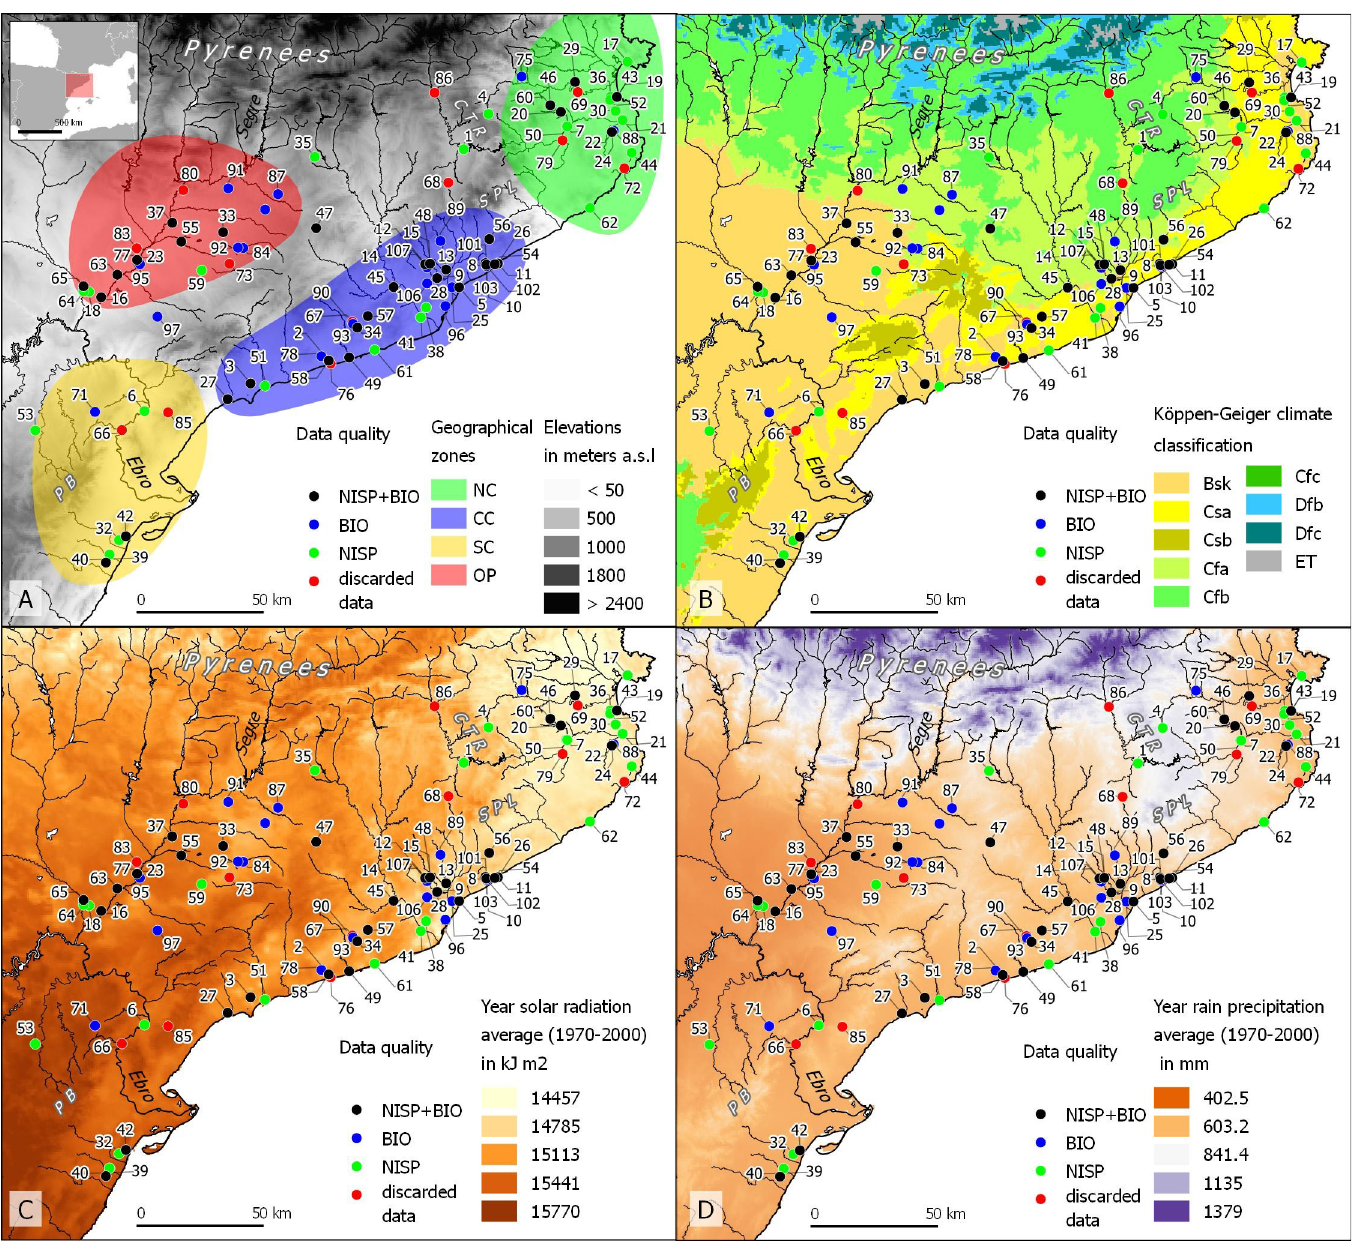
Fig 1. Map of NE Iberia with locations of the studied sites. A) Location of geographical areas (NC: North Coast, CC: Central Coast, SC: South Coast, OP: Occidental Plain) with sites colored depending of archaeozoological data availability (NISP: Counts by species, BIO: Biometrical data) with elevation map reprinted using open data from Geofabrik and the U.S. Geological Survey [55,56]; B) Ko¨ppen-Geiger climate classification reprinted from open data Zenodo [57]. The classification is based on threshold values and seasonality of monthly air temperature and precipitation. Considering vegetation as “crystallized, visible climate” C) Averages of year solar radiations between 1970–2000 [58]. D) Averages of rain precipitations between 1970–2000 [58] reprinted from WorldClim (CC-BY SA 4.0). List of sites: 1. Esquerda ; 2. Alorda Park; 3. Antigons; 4. Aubert; 5. Baetulo; 6.Barranc de G à fols; 7. Bosc del Congost; 8. Burriac; 9. Ca n’Oliver; 10. Can Bartomeu; 11. Can Cruzate; 12. Can Feu; 13. Turo´ de la Rovira; 14. Can Gambu´s 1; 14. Can Gambu´s 3; 15. Can Roqueta_DIASA; 15. Can Roqueta CRV; 15. Can Roqueta TR; 16. Carretel à ; 17.Ciutadella de Roses; 18. Cova Punta Farisa; 19. Empu´ries; 21. Fonollera; 22. Gou Batlle; 23. Ilerda 1; 23. Ilerda; 23. Ilerda 2; 24. Illa d’en Reixac; 25. Puig Castellar; 26. Iluro_VI_VII; 27. La Llosa; 28. Mallols; 29. Mas Castellar rural; 29. Mas Castellar fortificat; 29. Mas Castellar; 30. Mas Guso´; 32. Moleta del Remei 1_1; 33. Molı´d’Espı´gol; 34. Ol è rdola; 35. Olius; 36. Olivet d’en Pujol; 37. La Pedrera; 38. Penya del Moro; 39. Puig de la Misericordia; 40. Puig de la Nau; 41. Sant Boi_Pl Constitucio´; 42. Sant Jaume Mas d’en Serr à ; 43. Sant Martı´Empu ´ ries; 44. Sant Sebasti à de la Guarda; 45. Santa Margarida; 46. Saus; 47. Sigarra; 48. Sitges UAB; 49. Solana; 50. St. Juli à de Ramis; 51. Tarraco; 52. Tolegassos; 53. Torre Cremada; 54. Torre Llauder; 55. Tossal Molinet; 56. Turo´ del Vent; 57. Turo´ Font de la Canya; 58. Vilarenc; 59. Vilars; 60. Vilauba; 61. Vil � la Vinyet; 62. Vil � la dels Ametllers; 63. Vilot de Montagut; 64.Vincamet; 65. Zafranales; 68. Camp de les Lloses; 69. Camp Gran-Camp d’en Pitu Porrusia; 70. Can Cruzate; 71. Coll del Moro; 72. Collet de Sant Antoni; 73. Estinclells; 74. Fonollera; 76. Les Guardies; 77. Lleida_Carrer Bafart; 78. Mas d’en Gual; 79. Mas Xirgu`; 80. Monter ò ; 82. Puig de la Misericordia; 84. Rosella; 83.